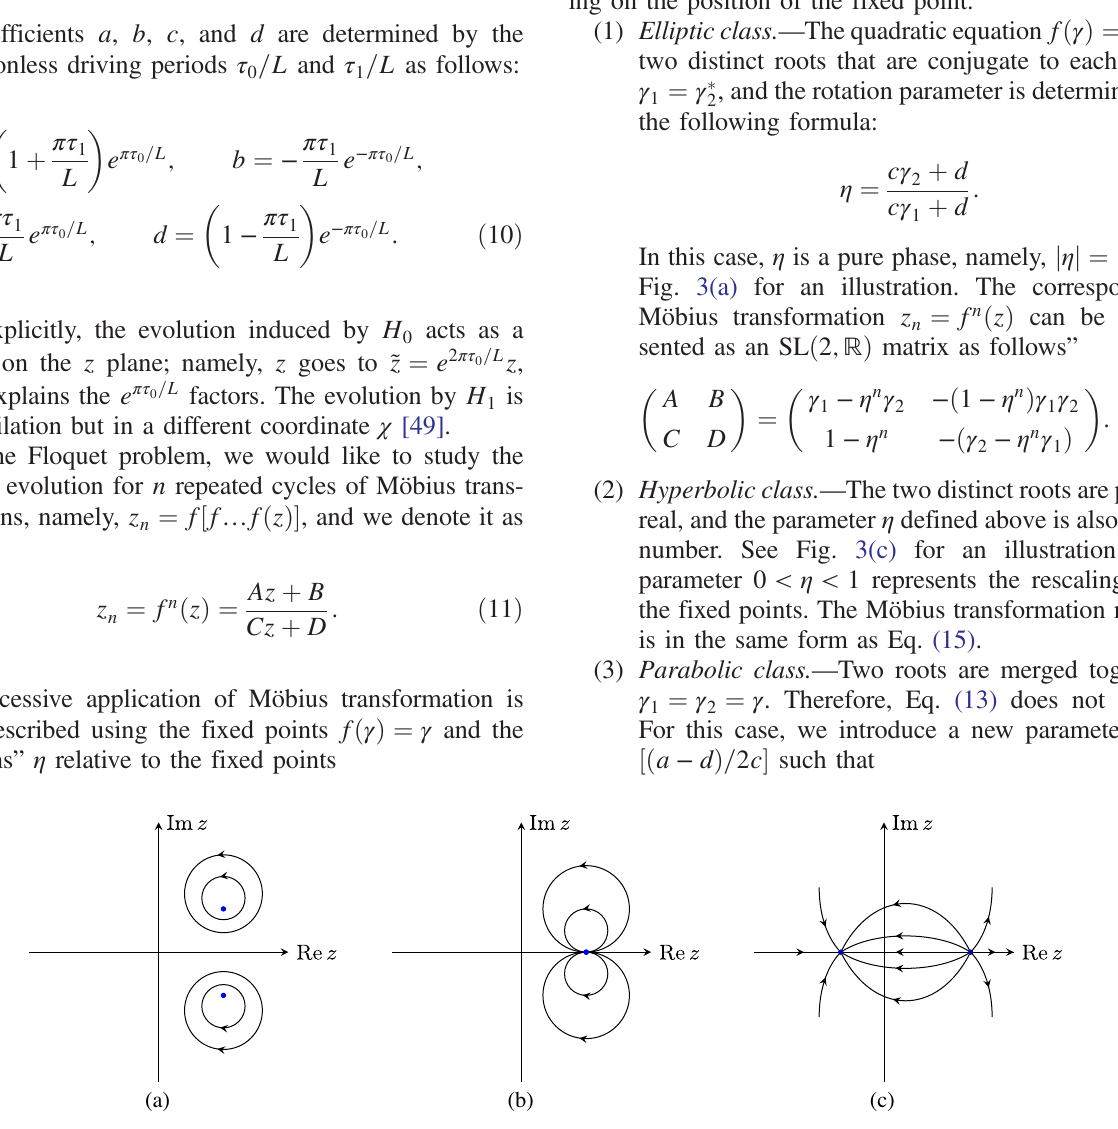
FIG. 3. Three classes of Möbius transformation: (a) elliptic, where two fixed points are two conjugate roots, and the orbits are circulating the fixed points; (b) parabolic, where the two fixed points coincide; (c) hyperbolic, where two fixed points are two real